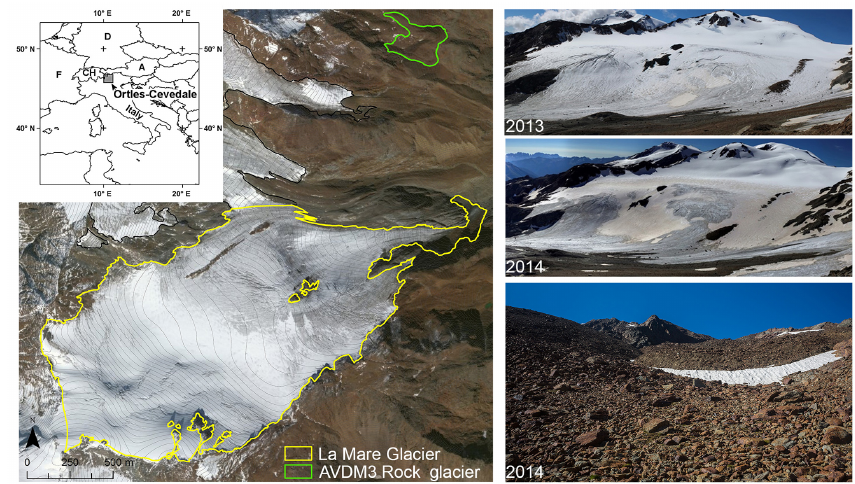
Figure 1. Geographic setting of study areas. Panoramic view of the La Mare Glacier from the same camera position on 4 September 2013 and 27 September 2014. The lower right photograph shows the front of the meridional lobe of the AVDM3 Rock glacier, which was surveyed on 27 September